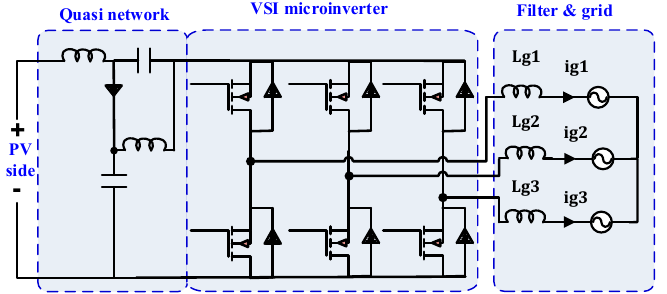
Figure 12. Structure of quasi Z-source invertor (ZSI) topology [100].